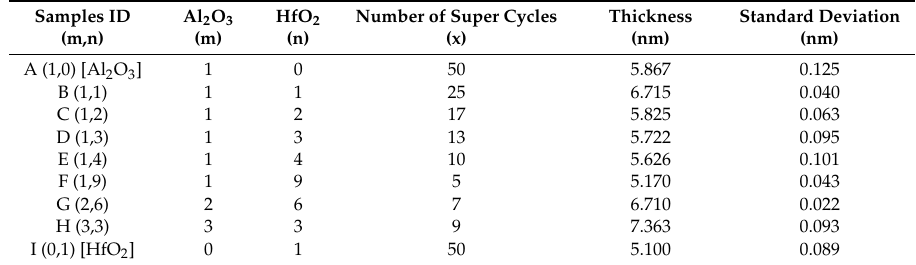
Supercycle design summary for formation of HfAlO alloy along with deposited physical